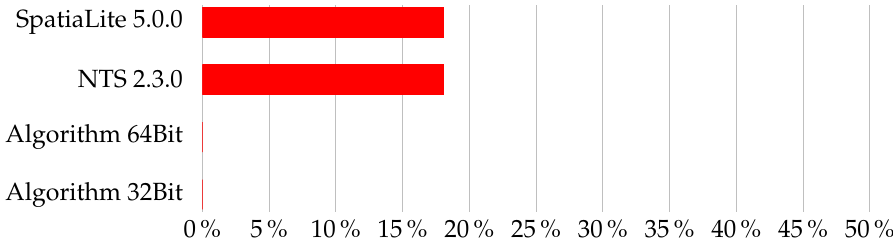
Figure 13. Failed translations (percent of total 1980 tests).